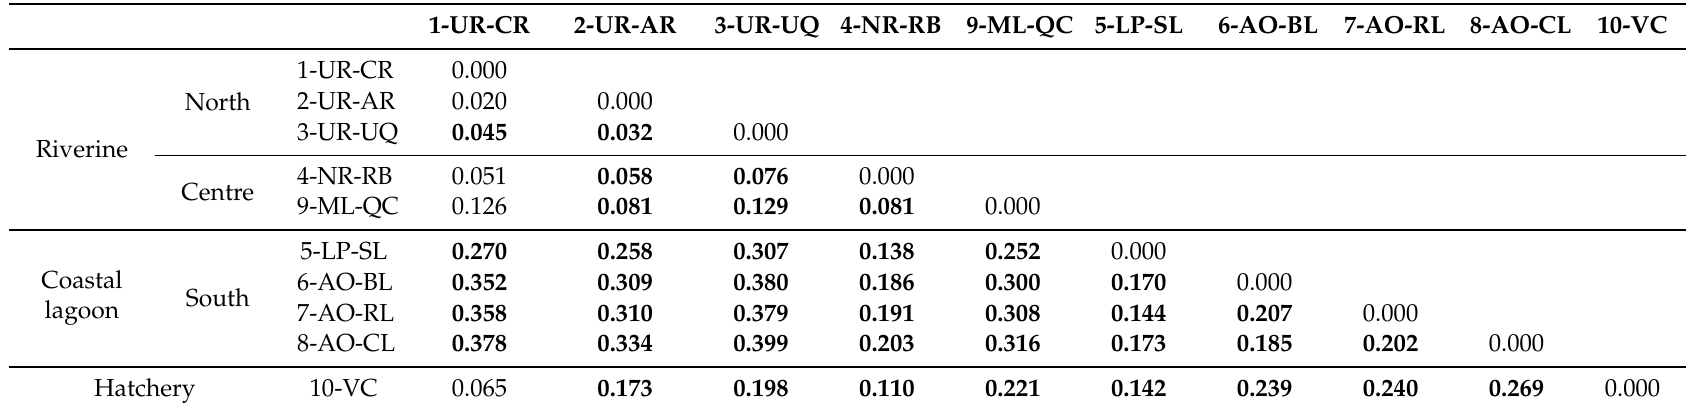
Table 5. Pairwise F ST values based on 15,584 SNP neutral loci dataset between localities. Significant FST values are highlighted in bold type ( p <